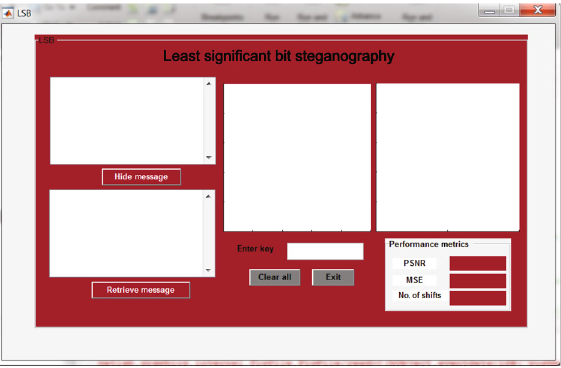
Figure 3: Interface of the system.